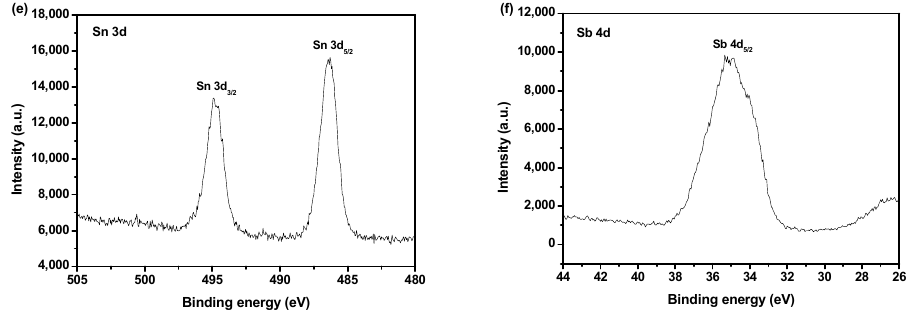
Figure 11. ( a ) XPS spectra of O 2− derived from the IBHP; ( b ) XPS spectra of In 3+ derived from the IBHP; ( c ) XPS spectra of Y 3+ derived from the IBHP; ( d ) XPS spectra of Bi 3+ derived from the IBHP; ( e ) XPS spectra of Sn 4+ derived from the IBHP; ( f ) XPS spectra of Sb 5+ derived from the IBHP.